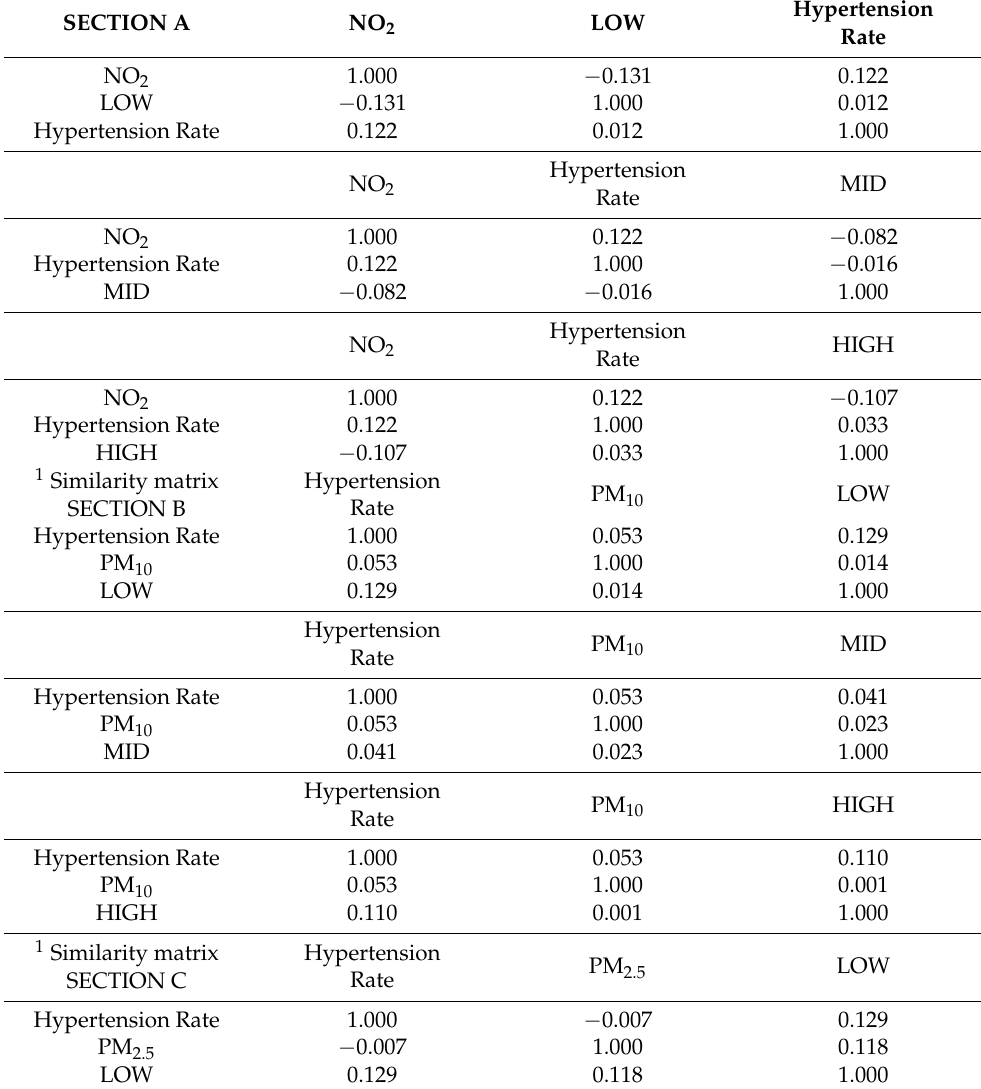
Table 4. Distance correlation between the vector values of joint noise level at different frequency components and air concentration and hypertension rate using a similarity